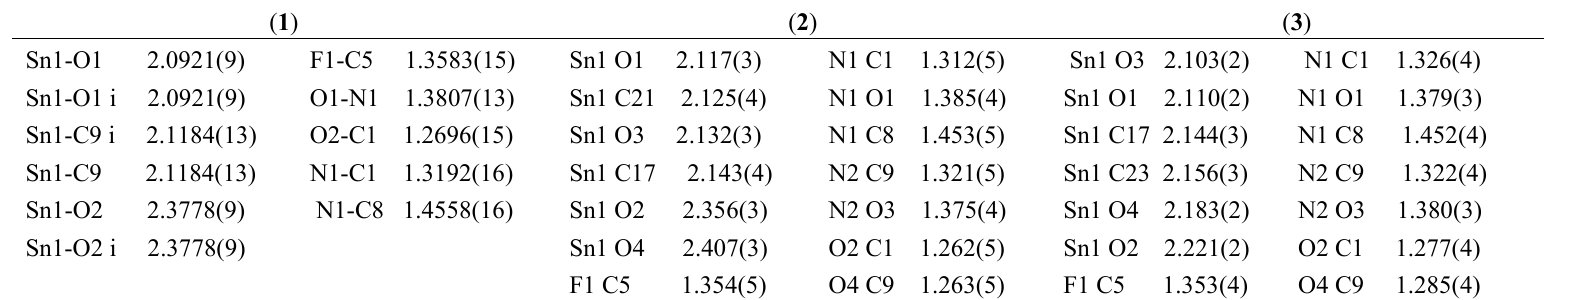
Table 1. Selected bond lengths (Å) of the complexes ( 1 ), ( 2 ) and ( 3 ).